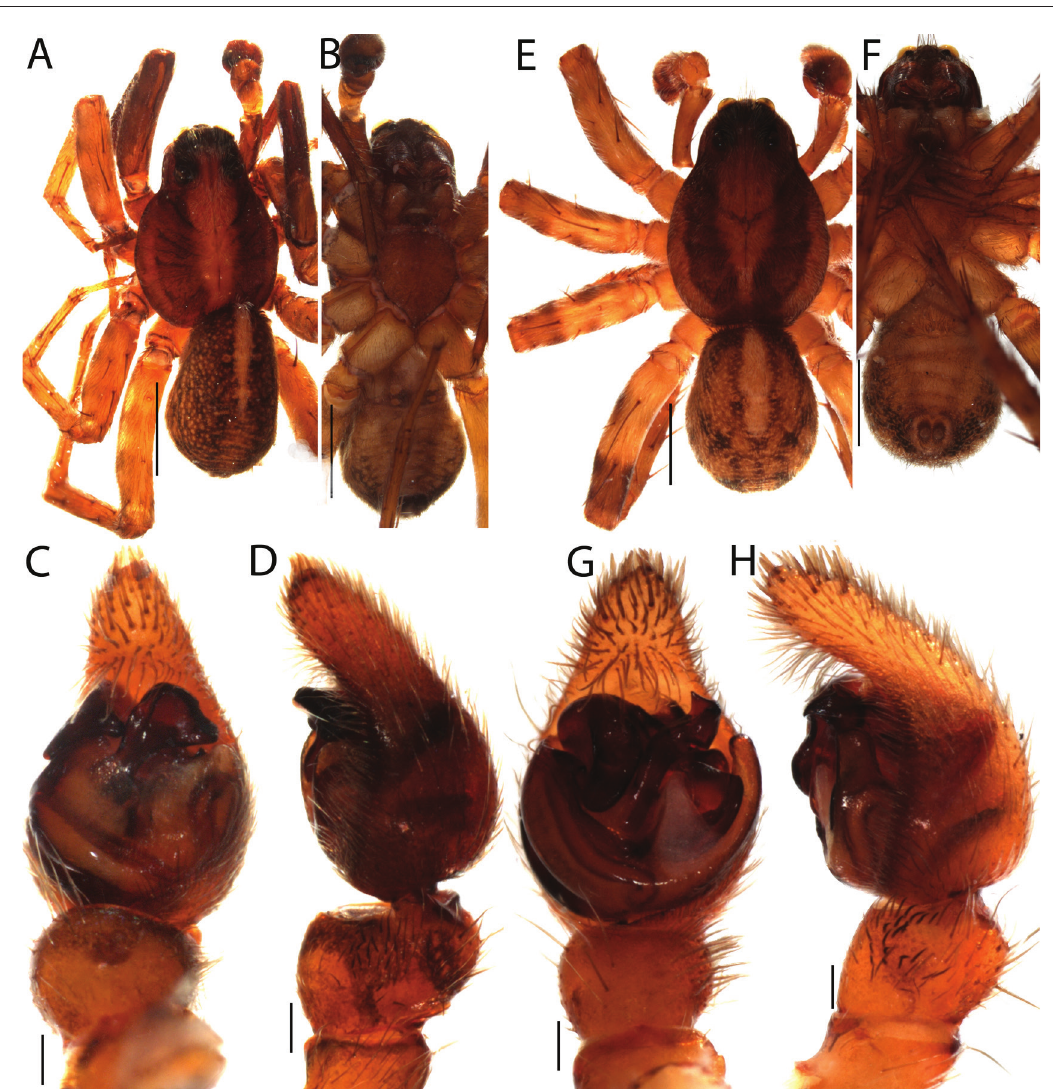
Figure 26. A–D , Artoria kanangra sp. n., male holotype (AM KS45008), E–H , A. kerewong sp. n., male holotype (AM KS16162): A , habitus, dorsal view; B , habitus, ventral view; C , male pedipalp, ventral view; D , male pedipalp, retrolateral view; E , habitus, dorsal view; F , habitus, ventral view; G , male pedipalp, ventral view; H , male pedipalp, retrolateral view. Scale bars: habitus 1.0 mm; pedipalp 0.1